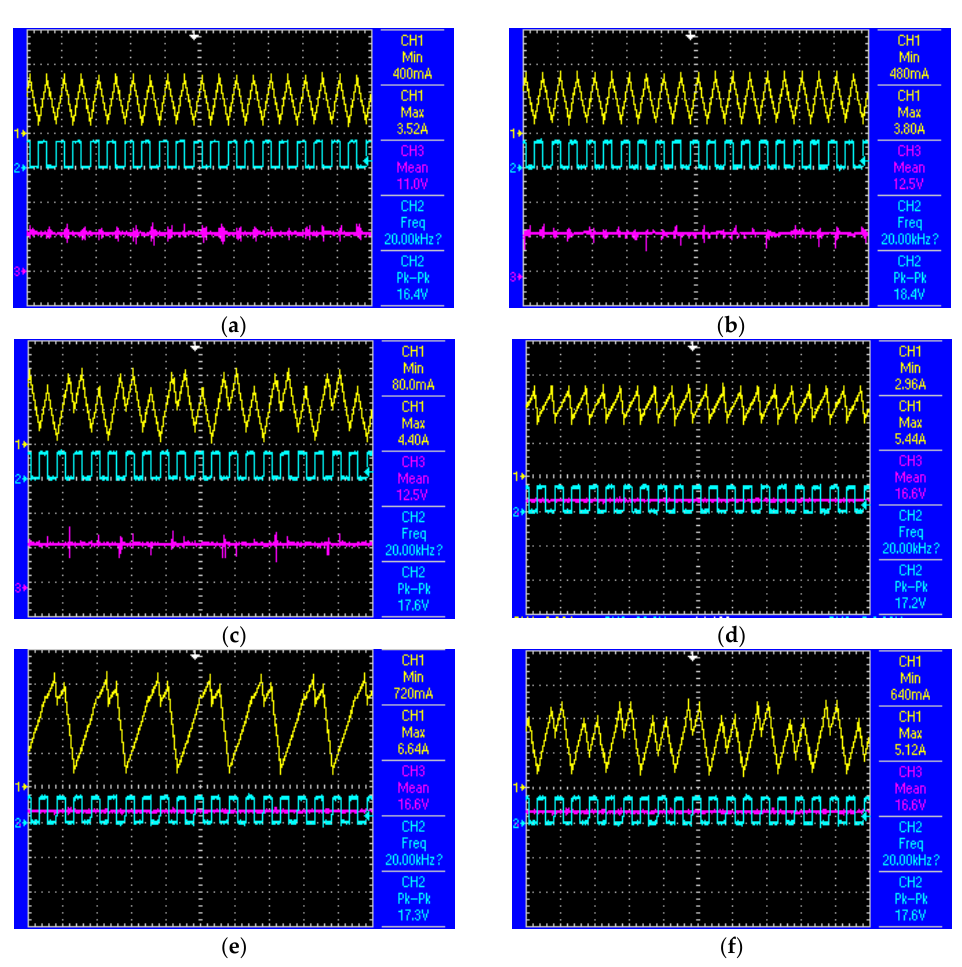
Figure 6. Experiment results of the coexistence of attractors phenomena: ( a ) u ref = 11 V with period-one orbit; ( b ) u ref = 12.5 V with period-one orbit; ( c ) u ref = 12.5 V with period-three orbit; ( d ) u ref = 16.6 V with period-one orbit; ( e ) u ref = 16.6 V with period-three orbit; ( f ) u ref = 16.6 V with period-four orbit.